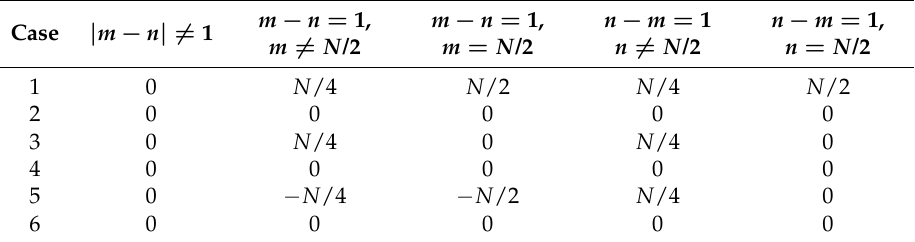
Table A1. Series sum results for each case of sine/cosine combination assuming an even number of magnetic bearing